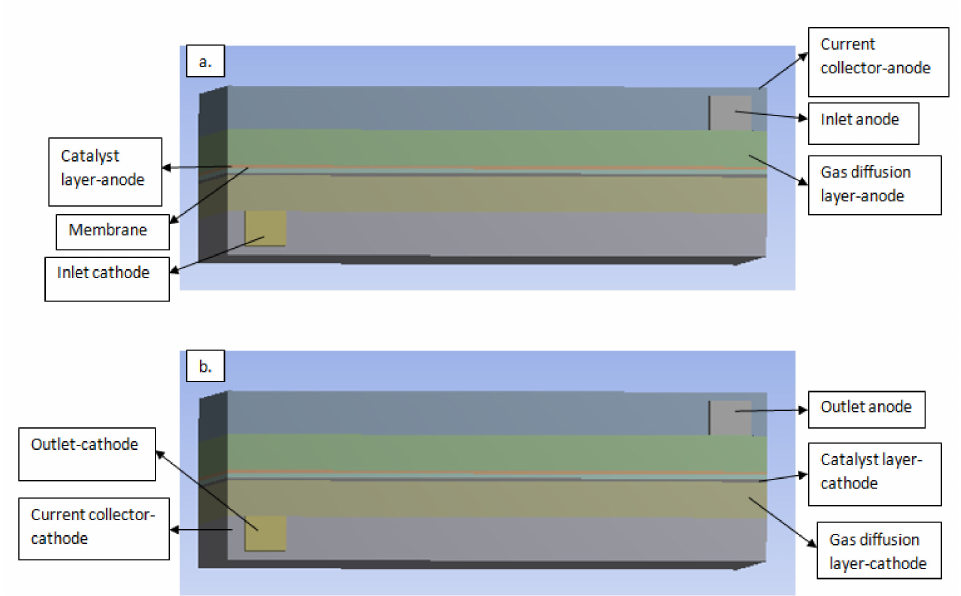
Figure 3. A three-dimensional view of the single PEM fuel cell and its components. ( a ) Inlet channel ( b ) outlet channel.